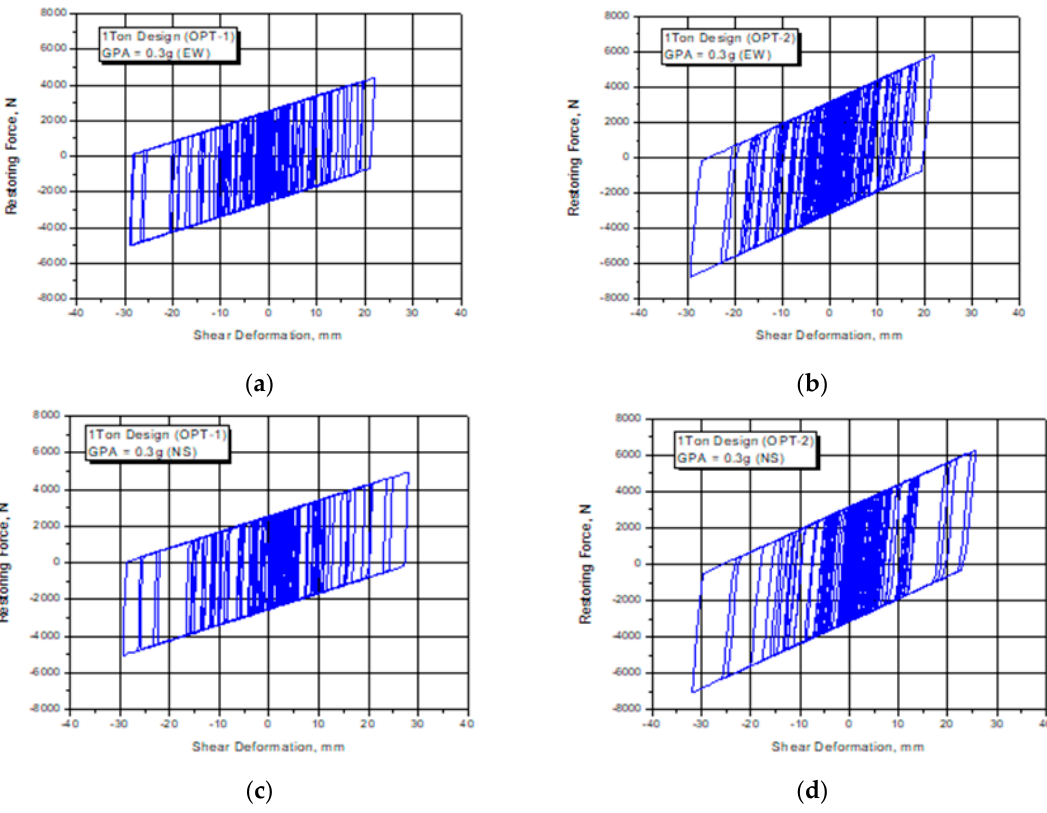
Figure 5. Hysteresis responses for PGA = 0.3 g: ( a ) OPT-1 (EW); ( b ) OPT-2 (EW); ( c ) OPT-1 (NS); and ( d ) OPT-2 (NS).